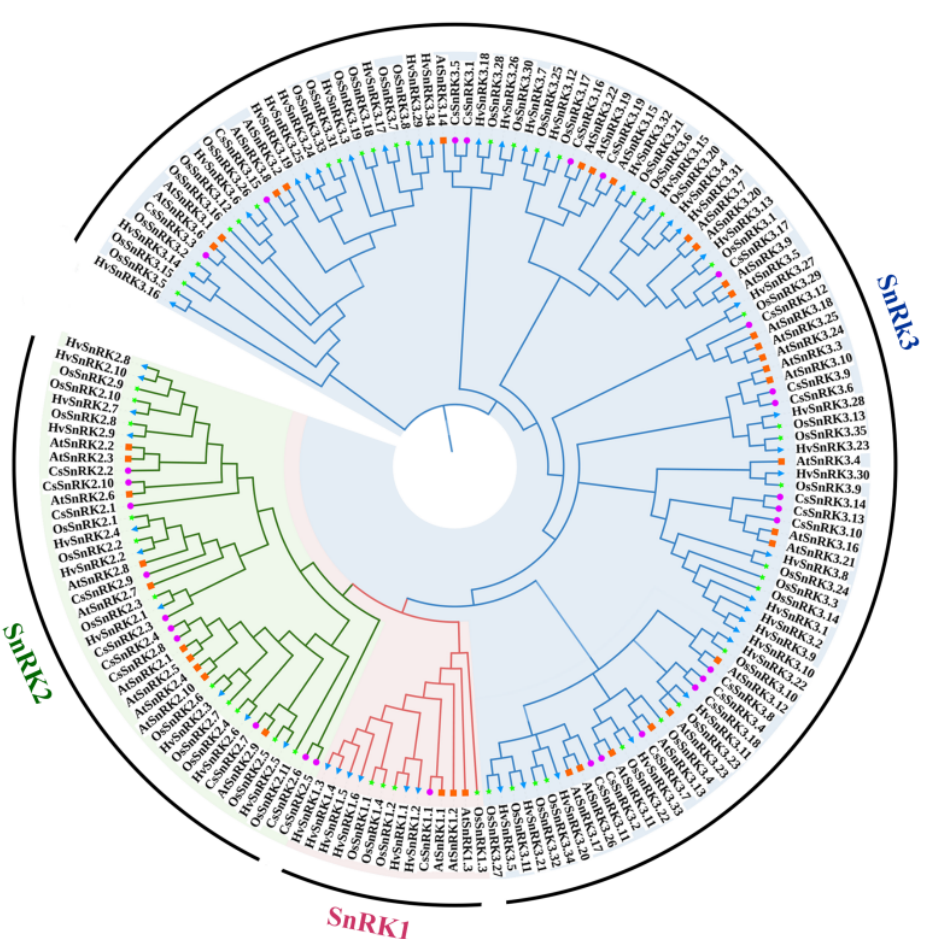
Figure 1. Phylogenetic relationship of the SnRK homologs in different species. The four differently- colored shapes represent SnRK proteins from four species. The orange rectangle, green pentacle, blue triangle and purple round represent Arabidopsis , rice, barley and cucumber SnRK proteins, respectively. Different color sectors represent SnRKs from SnRK1 subfamilies (blue), SnRK2 (pink) and SnRK3 (green).